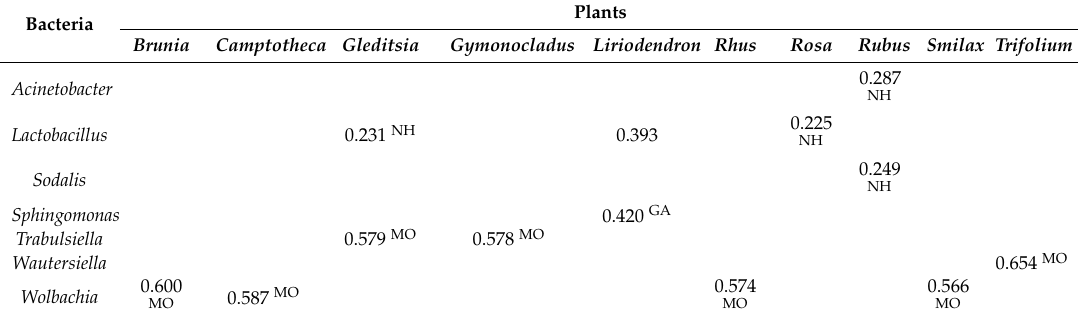
Table 1. Correlations coefficients between plant and bacteria genera as identified by SparCC. Only significant positive correlations are shown that were also found to be significant in CoNet ( p ≤ 0.01). Superscripts notate significant correlations found when analyses were restricted to Georgia ( GA ), Missouri ( MO ) or New Hampshire ( NH ).